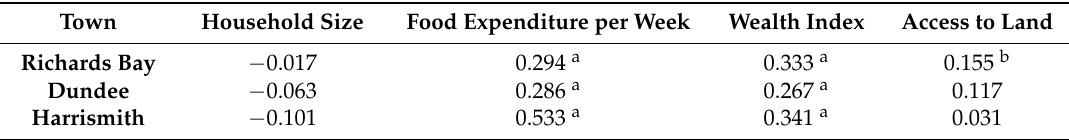
Table 3. Spearman correlations between MDD-W and selected socioeconomic indicators in the three towns.